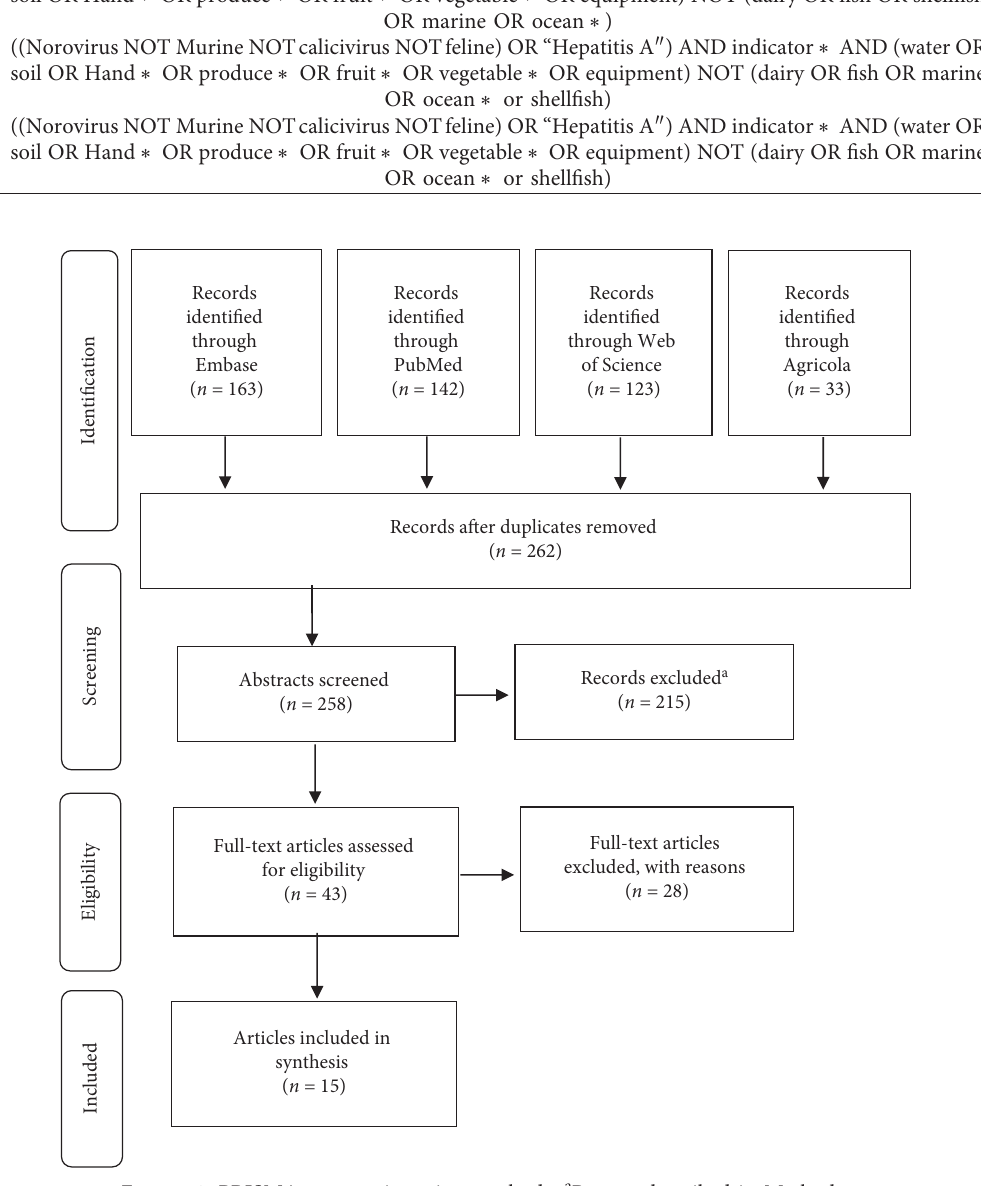
Figure 1: PRISMA systematic review methods. a Reason described in